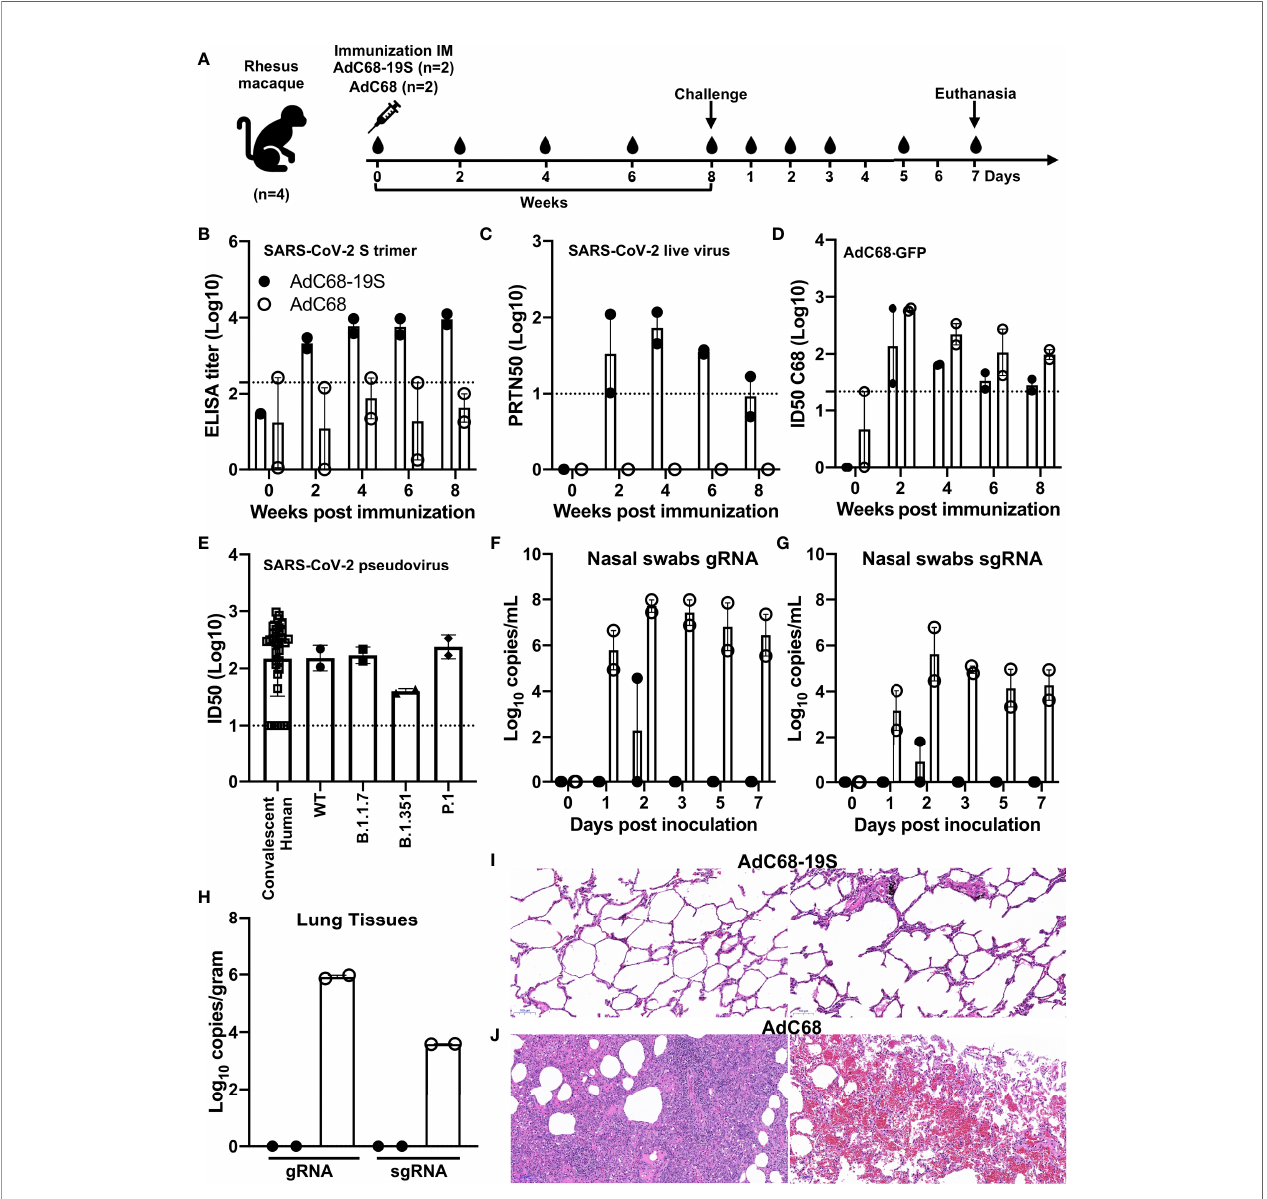
FIGURE 4 | AdC68-19S induces protective immune responses in rhesus macaques. (A) Timeline for vaccination, challenge, euthanasia, and virological and immunological characterization. Four animals were intramuscularly immunized with 10 11 vp of AdC68-19S (n = 2) or 10 11 vp of the empty AdC68 vector (n = 2). Eight weeks post-immunization, the animals were challenged with 10 6 PFU of live SARS-CoV-2. Blood samples were collected every 2 weeks before viral challenge. Blood samples and nasal swabs were collected on days 0, 1, 2, 3, 5, and 7 after the challenge. All animals were euthanized on day 7 after the challenge to quantify the viral load in the lung tissue and conduct histopathological examinations. Binding activity of immune serum total IgG to the SARS-CoV-2 S trimer (B) . Neutralizing activity of immune serum against live SARS-CoV-2 (C) . (D) AdC68-vector neutralizing antibodies in serums were assessed by AdC68-GFP neutralization assays. (E) Neutralizing activity of immune sera from convalescent patients and rhesus macaques 6 weeks post IM immunization in pseudovirus neutralization against the WT strain and variants. Viral gRNA and sgRNA copies in nasal swabs (F , G) and in lung tissue samples from six lobes (H) were quanti fi ed by droplet digital PCR (TargetingOne, China). (I, J) Histopathological comparison of tissues from animals vaccinated with AdC68-S and AdC68. Representative tissue sections in standard hematoxylin and eosin staining are shown (10×). The scale bar is 100 m m. Data corresponding to animals in the AdC68-19S group are shown in solid circle, and those in the control group in hollow circle. Dotted lines re fl ect assay limit of detection. All data are presented as the means ±